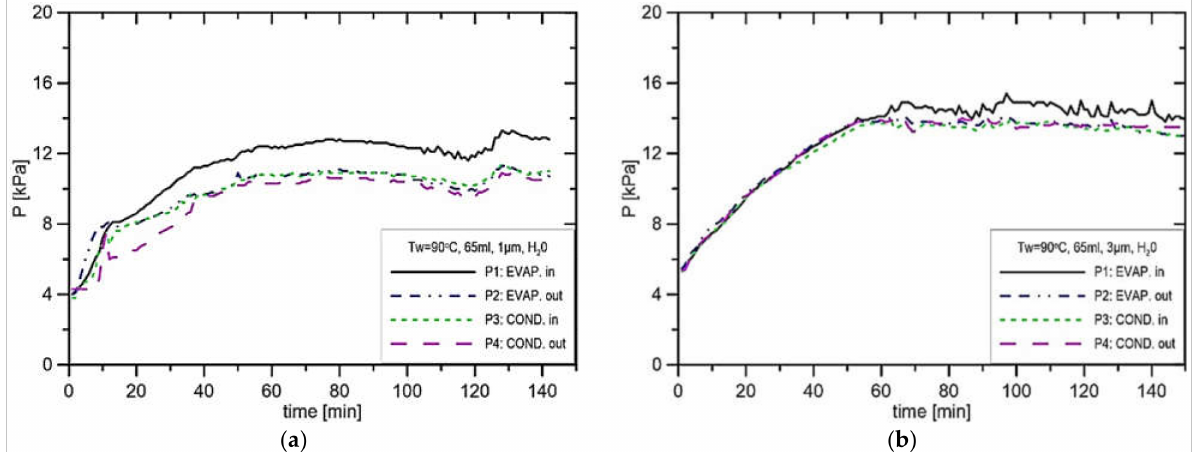
Figure 10. Distribution of pressure in function of time in case of water, charge volume 65 mL, T w = 90 ◦ C, ( a ) R p = 1 µ m, ( b ) R p = 3 µ m.